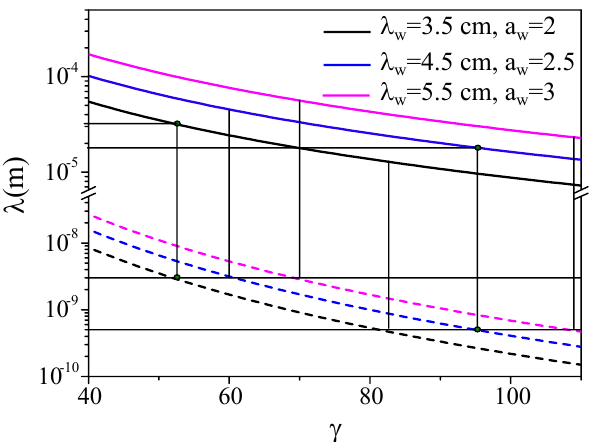
Figure 2. Wavelength of the THz and X-ray radiation vs. electron Lorentz factor γ . Solid lines: THz radiation produced with the FEL oscillator. Dashed lines: X-ray radiation generated by means of Thomson back-scattering. In black: λ w = 3.5 cm, a W = 2; similar values can also be obtained with λ w = 4.5 cm, a W = 1.7. In blue: λ w = 4.5 cm, a W = 2.5. In magenta: λ w = 5.5 cm, a W =